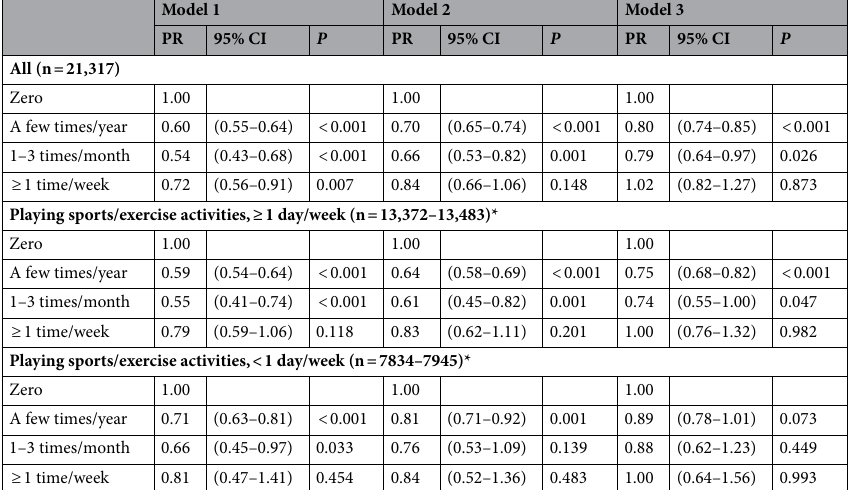
Table 2. Prevalence ratios (PRs) and 95% confidence intervals (CIs) of depressive symptoms according to frequency of watching sports on-site. *Estimation sample varies across imputations. Depressive symptoms were defined as a 15-item Geriatric Depression Scale score ≥ 5. Model 1, adjusted for sex and age groups. Model 2, model 1 + frequency of playing sports/exercise, marital status, living alone, occupational status, years of education, equivalent income, drinking, smoking, disease status, body mass index, and instrumental activities of daily living. Model 3, model 2 + general trust, norms of reciprocity, attachment to the neighborhood, frequency of meeting friends, and number of friends met.